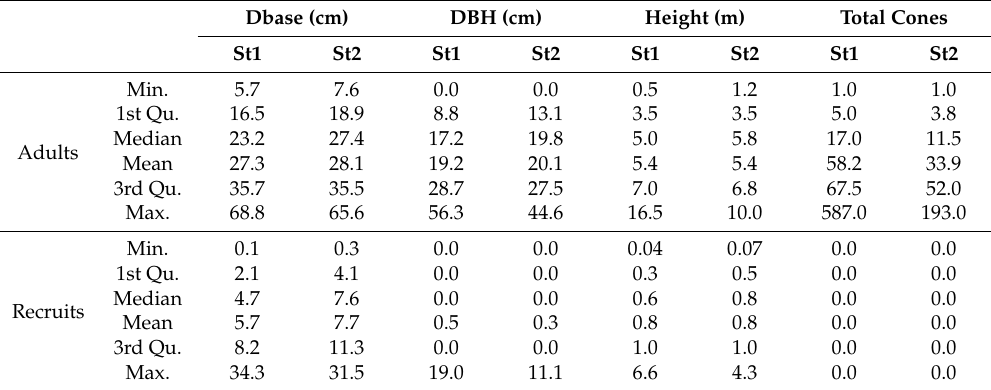
Table 2. Descriptive statistics for adults and recruits of both stands.